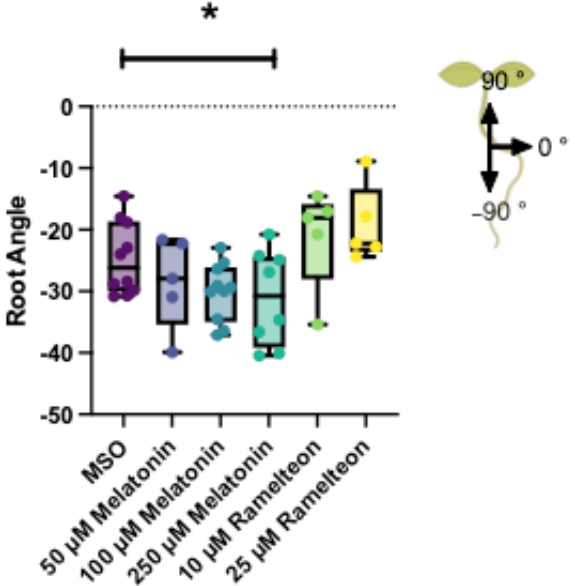
Figure 3. Gravitropic response of 14-day old Arabidopsis thaliana Col-0 seedlings in response to melatonin (blues) or ramelteon (green/yellow) treatment. Whiskers extend to the maximum and minimum values; boxes extend to first and third quartiles and central bar mean. Star indicates a significant linear trend (linear contrast) with increasing melatonin concentration using ANOVA with multiple comparisons, α = 0.05.